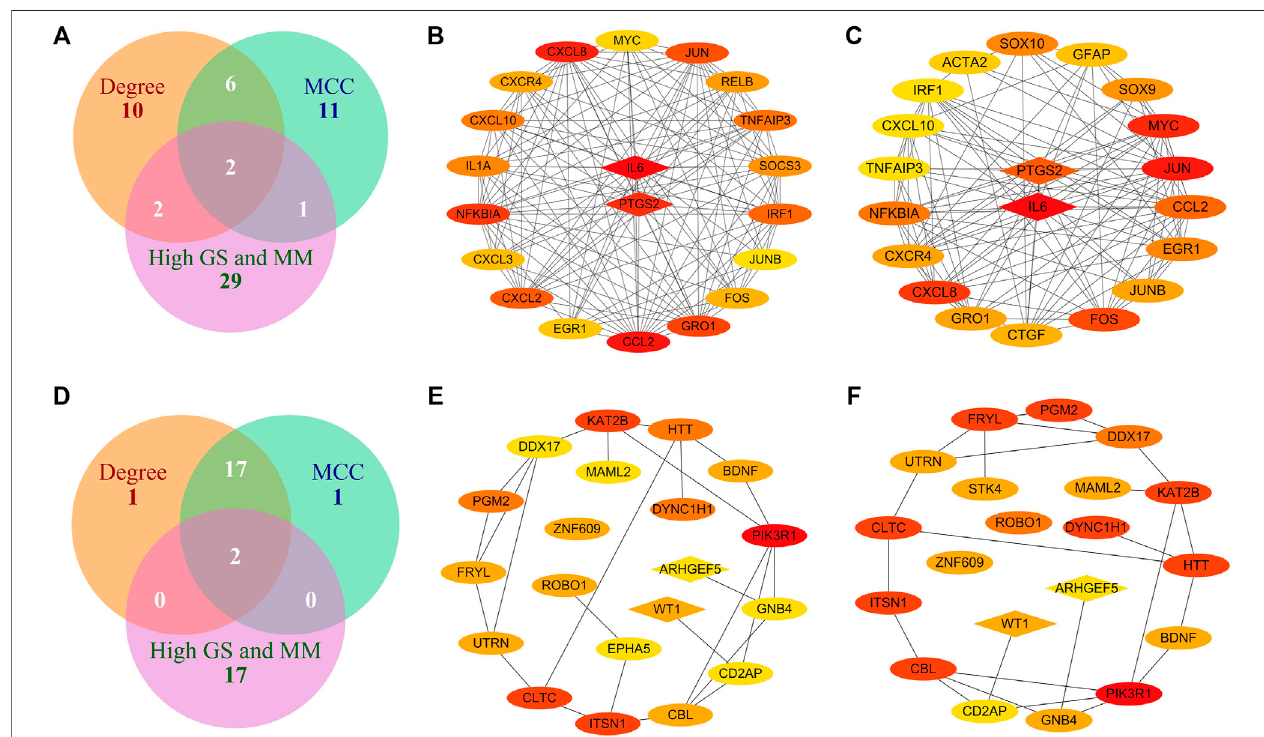
FIGURE 7 | Identi fi cation of hub genes in intramuscular and omental fat. (A) Intersection of genes with high MM and GS for intramuscular fat and the top 20 hub genes identi fi ed by MCC and Degree algorithms in the brown module; (B – C) Top 20 hub genes identi fi ed by MCC (B) and Degree (C) algorithms in the brown module; (D) Intersectionofgeneswithhigh MM and GSforomental fat and thetop20hub genesidenti fi ed byMCCand Degreealgorithmsinthe pinkmodule; (E – F) Top 20hub genes identi fi ed by MCC (E) and Degree (F) algorithms in the pink module (the redder color indicates the higher interaction